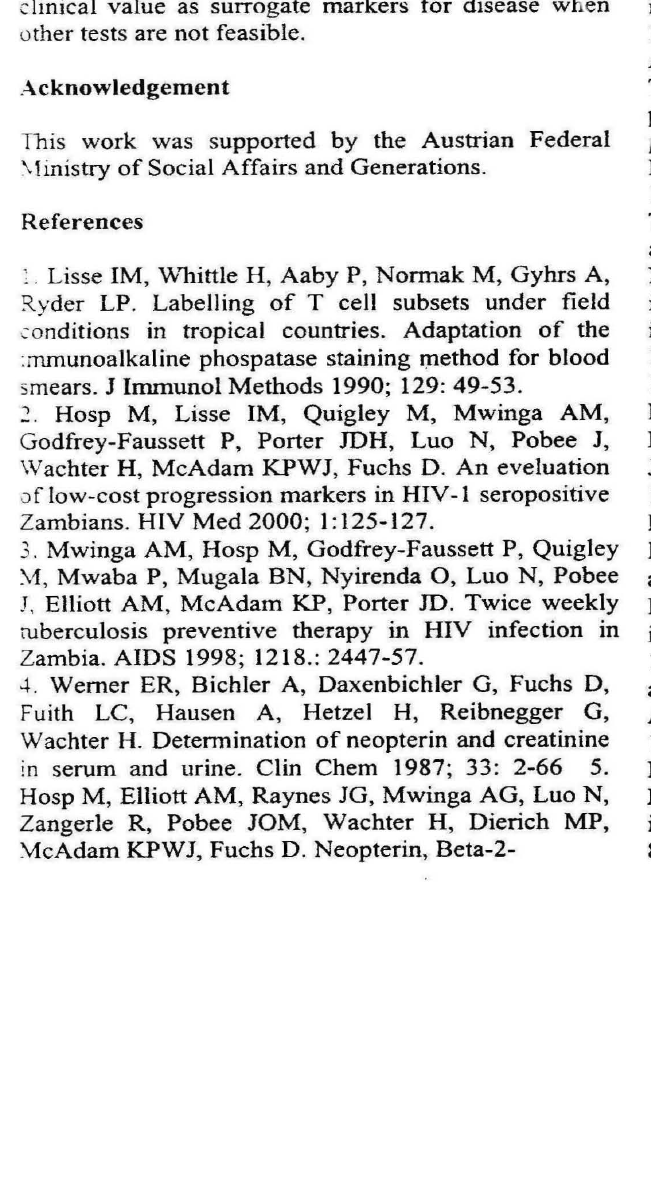
the clinical evaluation of HIV -infected A frican individuals or research study populations. In fome settings lymphocyte count and hemoglobin will b~~ of ;: linical value as surrogate markers for disease when other tests are not